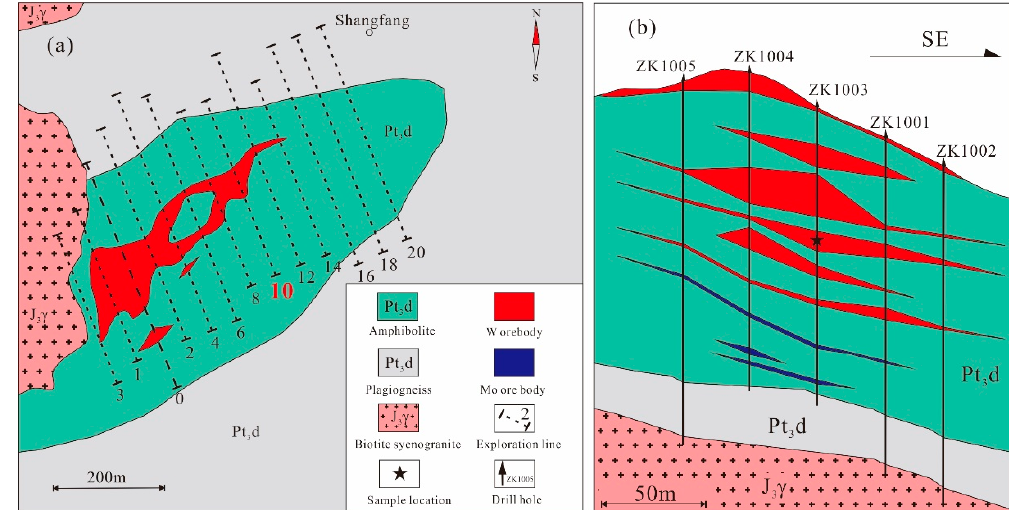
Figure 2. The geologic map ( a ), and representative cross ‐ section of No.10 exploration line ( b ) of the Shangfang W deposit, showing distribution and morphology of the W and Mo orebodies.